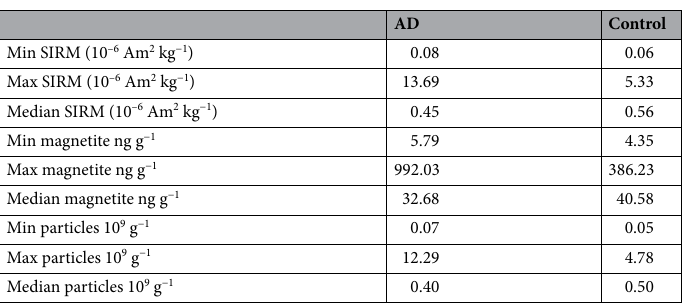
Table 1. Magnetite mass and particle number concentrations for human brain samples from AD and control brains from MBB, UK. Magnetite concentrations were calculated using an empirically-derived value for SIRM SP/SD magnetite of 13.8 Am 2 kg −1 , for interacting, mixed single domain (SD) and superparamagnetic (SP) magnetite, of mean particle size 31 nm 54 , rather than the ‘conventional’ SIRM magnetite value of 46 Am 2 kg −1 , applicable only to pure, non-interacting, single domain (~ 50 nm) magnetite particles. The number of magnetite particles/g dry tissue can then be estimated by dividing the mass of magnetite (per 1 g dry tissue wt) by the mass of 1 magnetite particle (8.07224 –11 µg). In the (unlikely) case that all of the brain ferrimagnetic material was maghemite, then the maghemite mass concentrations would be 15%